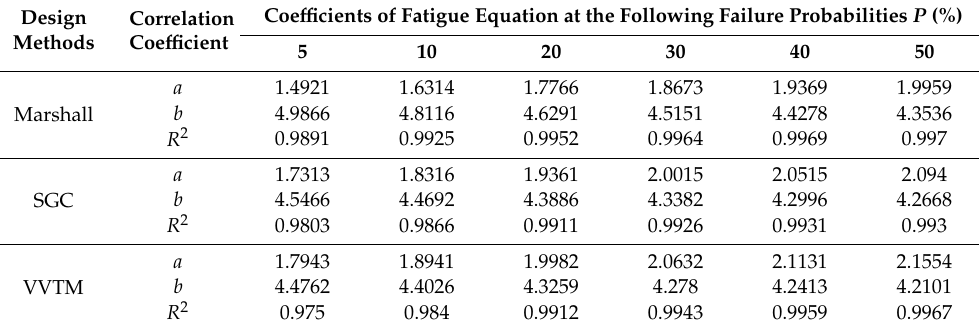
Table 19. Parameters and correlation coe ffi cients of the fatigue equation.